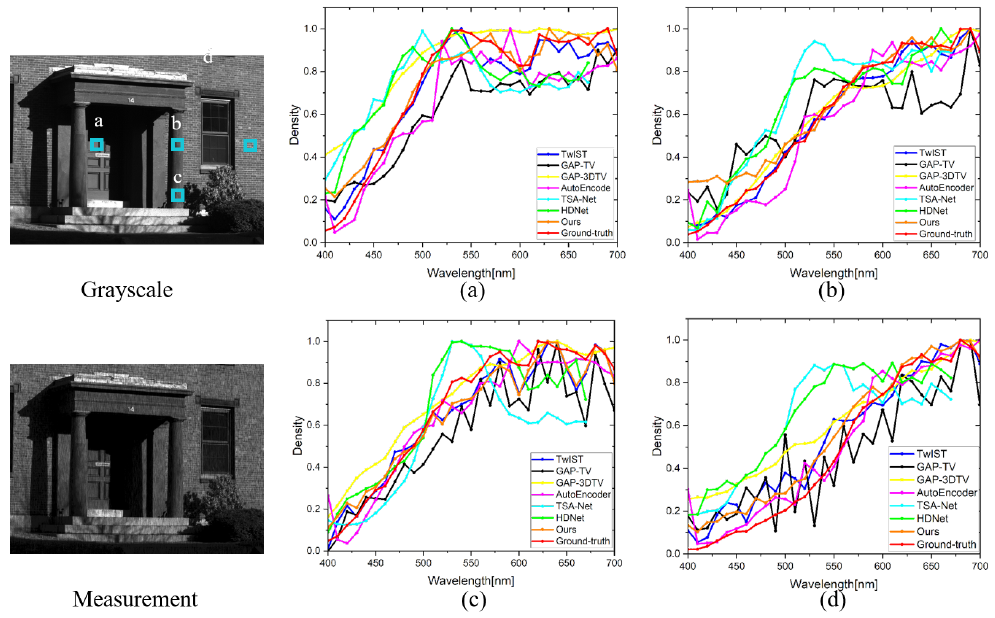
Figure 11. Grayscale image and corresponding compressive measurement by the spatio-spectral encoding from the Harvard dataset. The right two columns display the reconstructed spectral curves on special regions to compare the spectral accuracy. ( a ) The spectral curves at point a; ( b ) The spectral curves at point b; ( c ) The spectral curves at point c; ( d ) The spectral curves at point d.